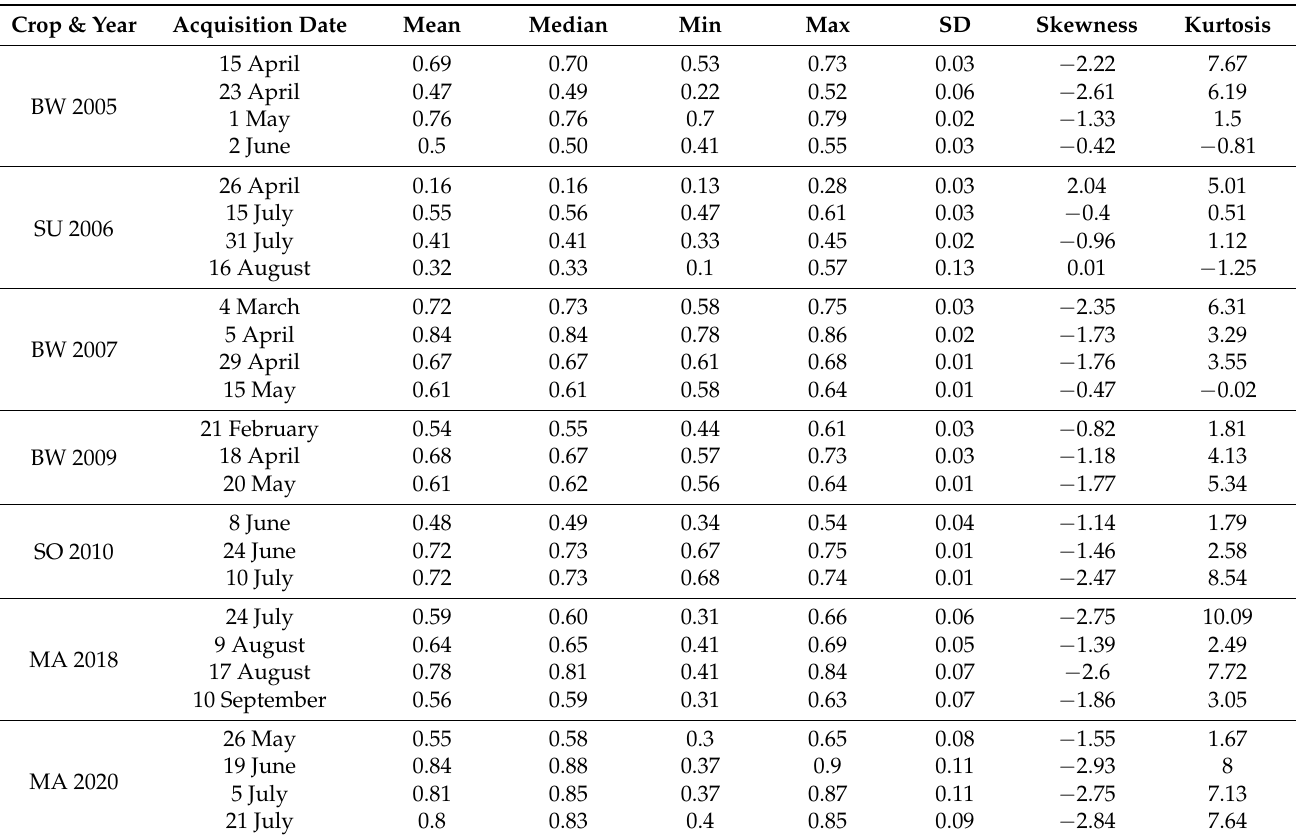
Table 9. Descriptive analysis of NDVI indices.